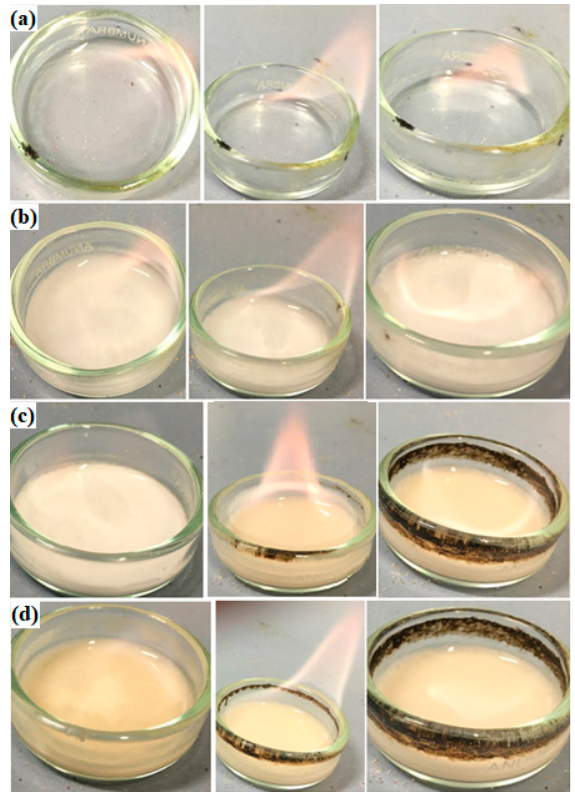
Figure 5. SET test using CS at the flame-retardant: ( a ) pure electrolyte; ( b ) 5% CS; ( c ) 10% CS; ( d ) 20% CS.